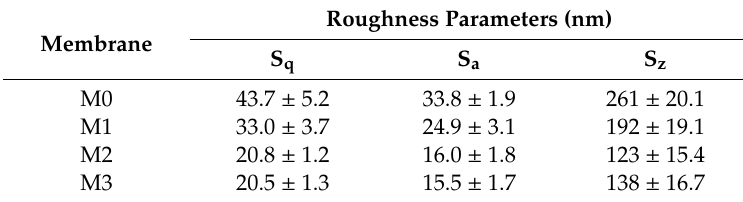
Figure 3. The atomic force microscopy (AFM) images of the prepared membranes: M0 ( a ); M1 ( b ); M2 ( c ); M3 ( d ). Table 1. Surface roughness parameters of the prepared membranes.